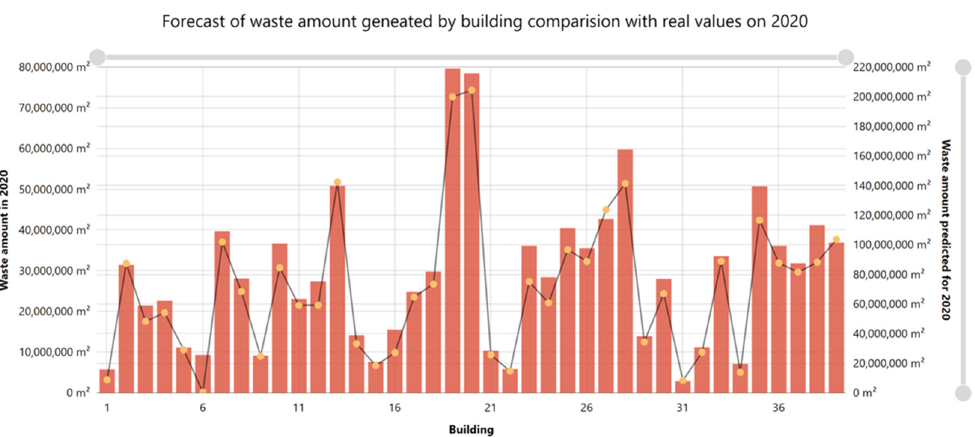
Figure 8. Comparison of responsible consumption based on waste generated in a city between 2020 and 2021.